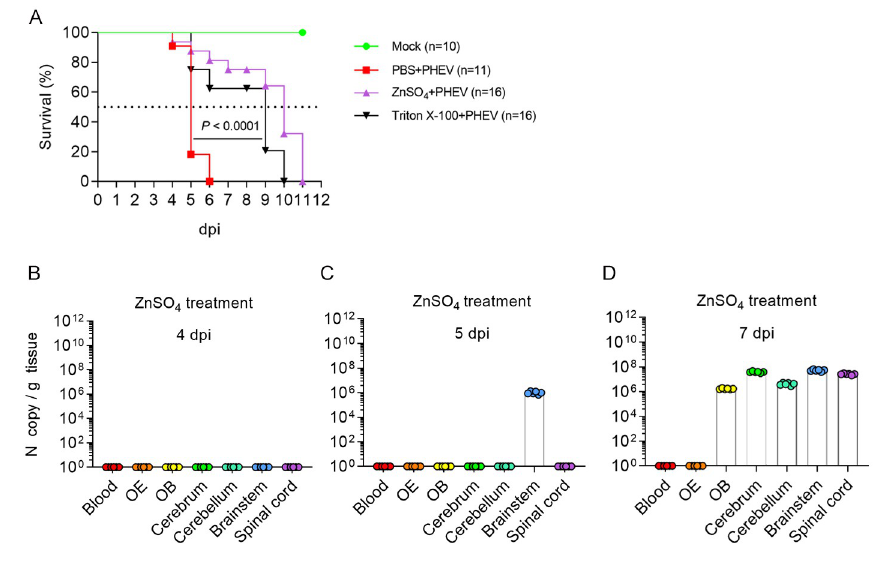
Fig 6. Chemical treatment delayed the time of animal death. (A) The 3w BALB/c mice were untreated (n = 10) or intranasally irrigated with 10 μ l of PBS (n = 11), ZnSO 4 (0.17 M) (n = 16), or a 0.7% Triton X-100 (n = 16) solution in both nostrils daily for 3 days before intranasal inoculation with 10 3.96 TCID 50 PHEV. The survival curves were plotted for these four groups. (B-D) The 3w BALB/c mice were intranasally irrigated with 10 μ l of ZnSO 4 (0.17 M) in both nostrils 3 days before intranasal inoculation with 10 3.96 TCID 50 PHEV. Mice were euthanized at different time points, and infected CNS tissues, OE, and blood were collected for PHEV N RNA quantification by qRT–PCR. Six mice per time point were analyzed. The Y axis represents the PHEV N RNA copy number per gram of